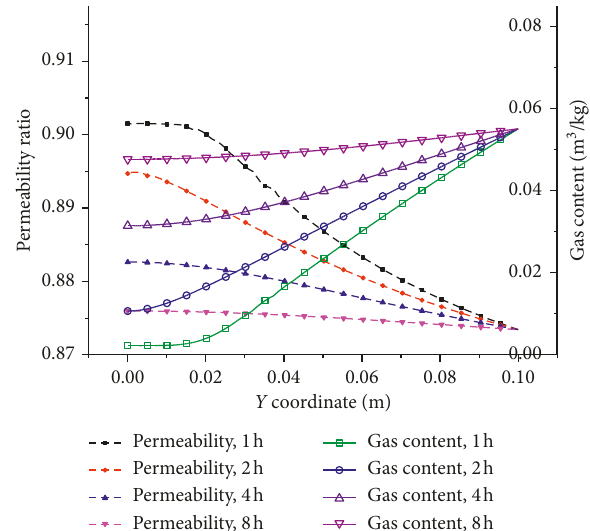
Figure 7: Permeability distribution along the monitoring